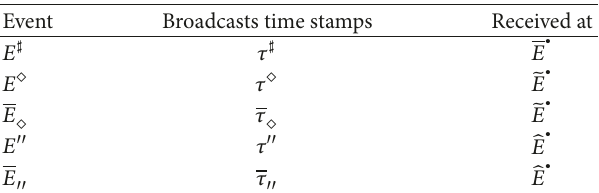
Table 9: The ternary events and their broadcast time stamps in the E ch